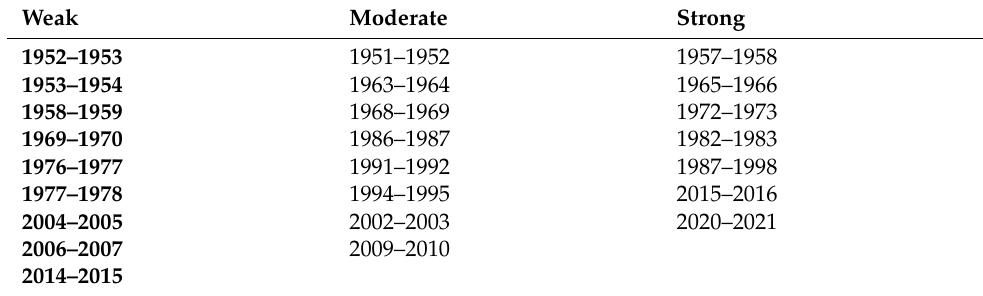
Table 2. Intensity of El Niño events from 1952 to 2020/21.